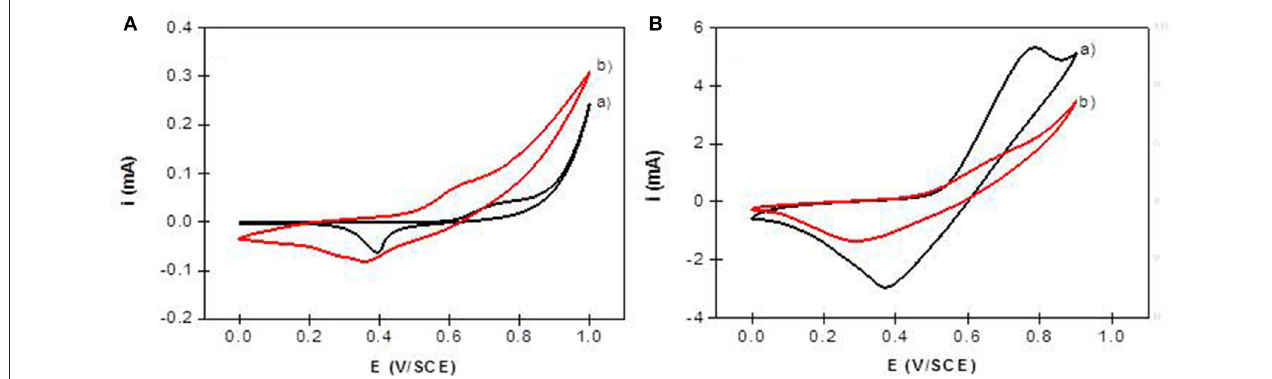
FIGURE 9 | Cyclic voltammograms recorded in 0.1M NaOH ( v 50 mVs − 1 ) using (A) NiAl-CO 3 /ITO (curve a) and NiAl-Alg/ITO (curve b) modified electrodes = prepared by solvent casting; (B) NiAl@alginate composite electrodes prepared by impregnation (a) NiAl@Alg-Ca/ITO and (b)